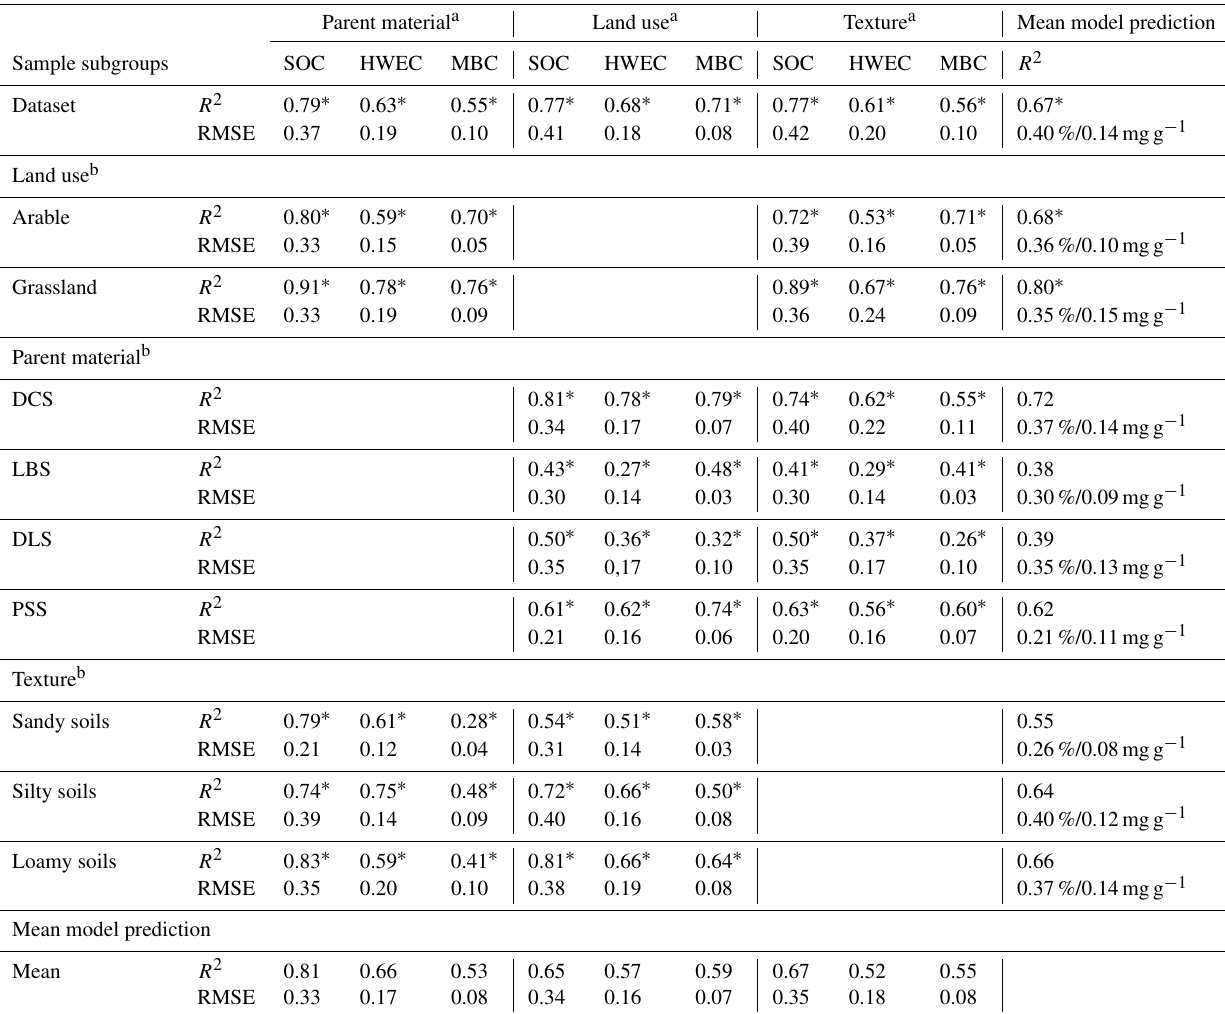
Table 5. R 2 and RMSE of the models for prediction of SOC, HWEC, and MBC based on the results of mixed-effect models. RMSE is given in % for SOC and in mgg − 1 for HWEC and